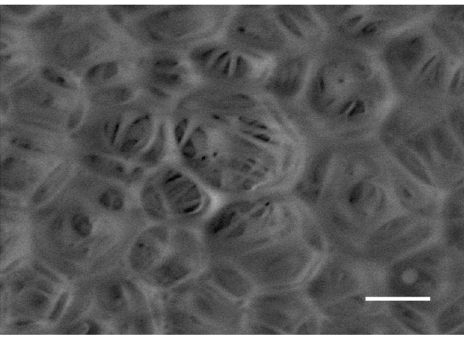
Figure 3. Effect of synthesis parameters on MS surface characteristics. Scale bar: 5 µm; magnifica- tion: 7000×.